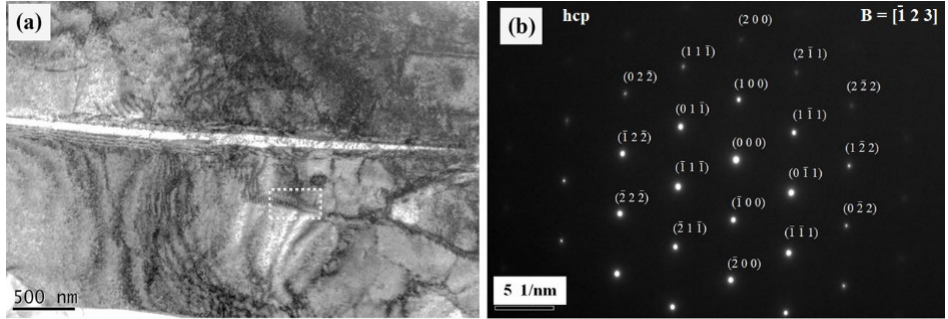
Figure 3. ( a ) TEM image of Ti-20Sn alloy and ( b ) SAED pattern for the selected region (white dotted rectangle).